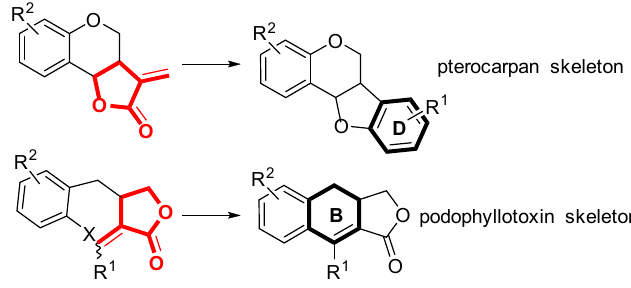
Figure 1. α -Ylidene γ -lactone as advanced intermediates in the synthesis of polycyclic skeletons.